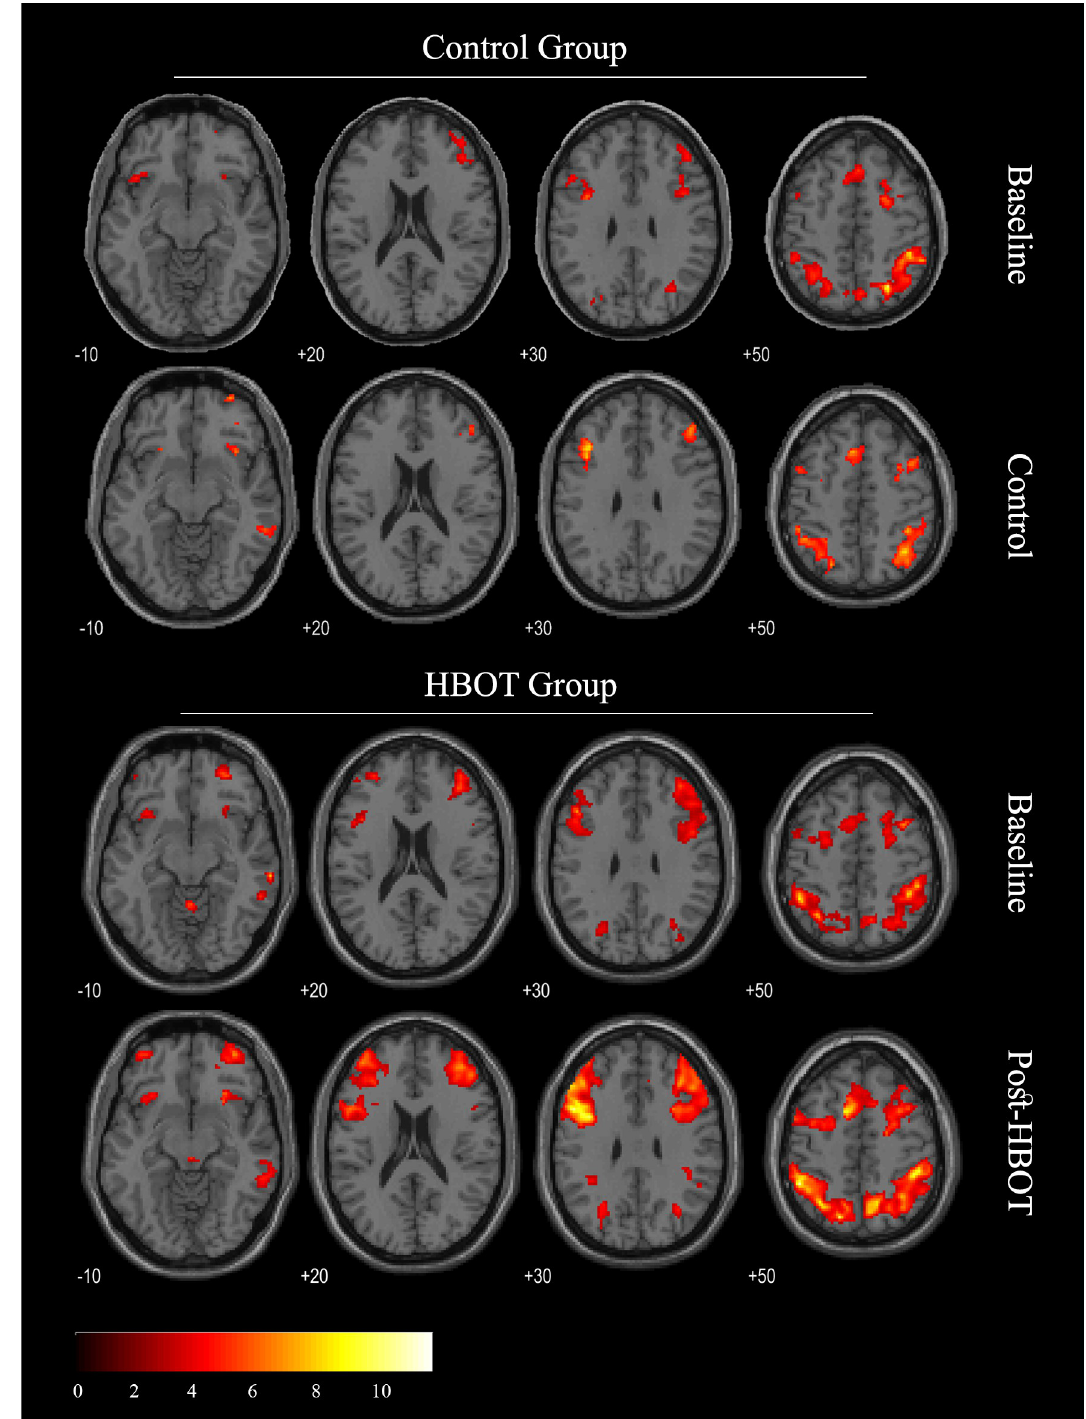
Fig 4. Main regional loci of brain activation in a verbal working memory task (2-Back– 0-Back) Group analysis, p < 0.05, FDR corrected.